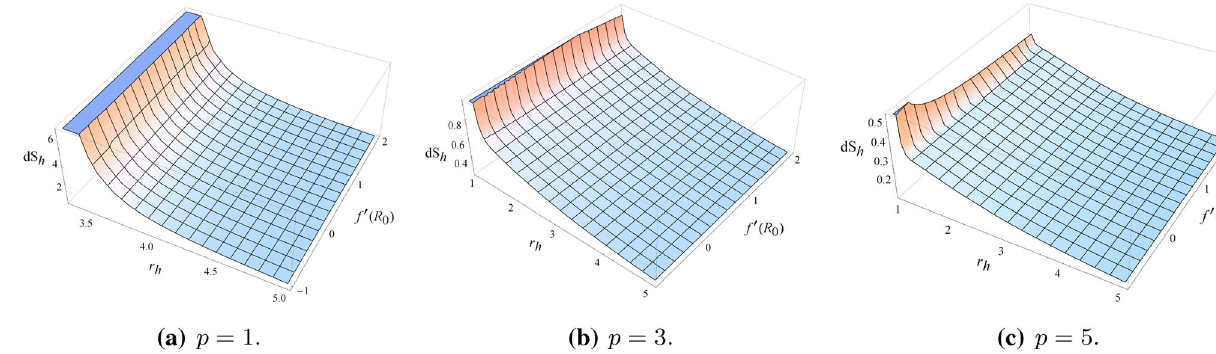
Fig. 1 The relation between dS h and r h for the condition − 1 < f (cid:2) ( R 0